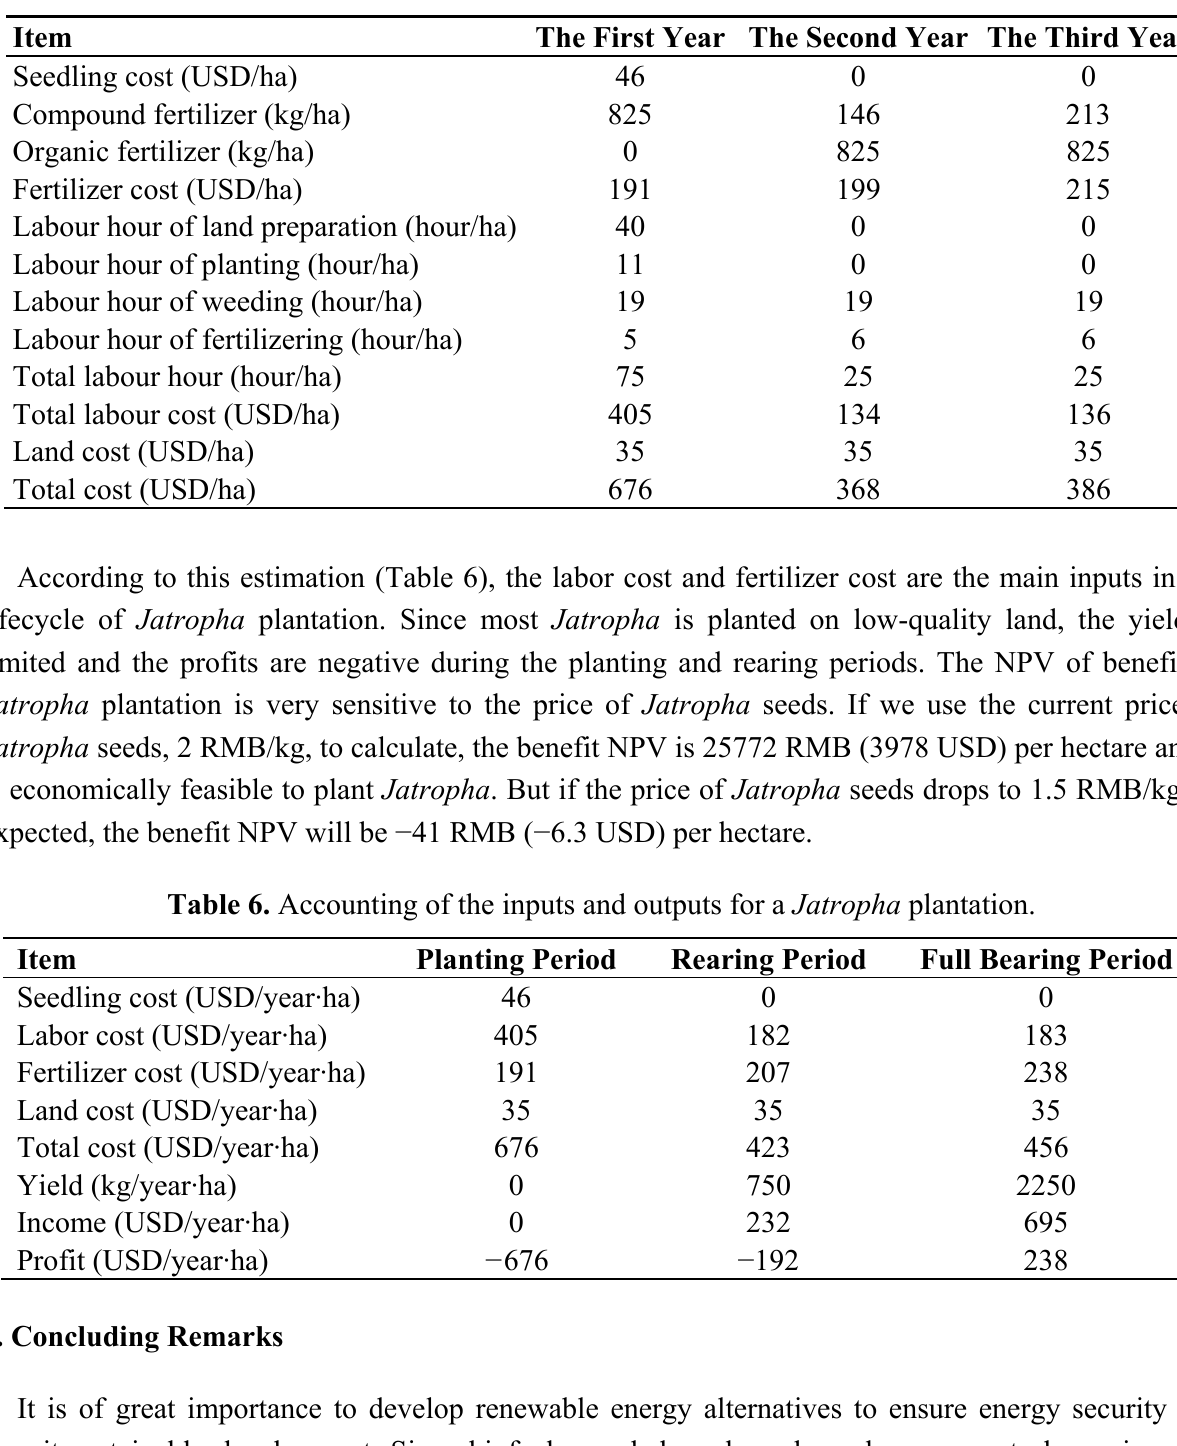
Table 5. Cost of planting Jatropha for the first three years.